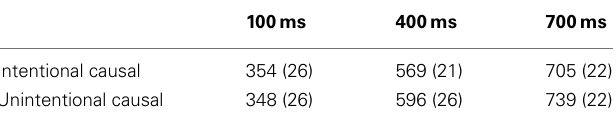
TableA1 |Average interval estimate (ms) for each interval length in the intentional causal and unintentional causal